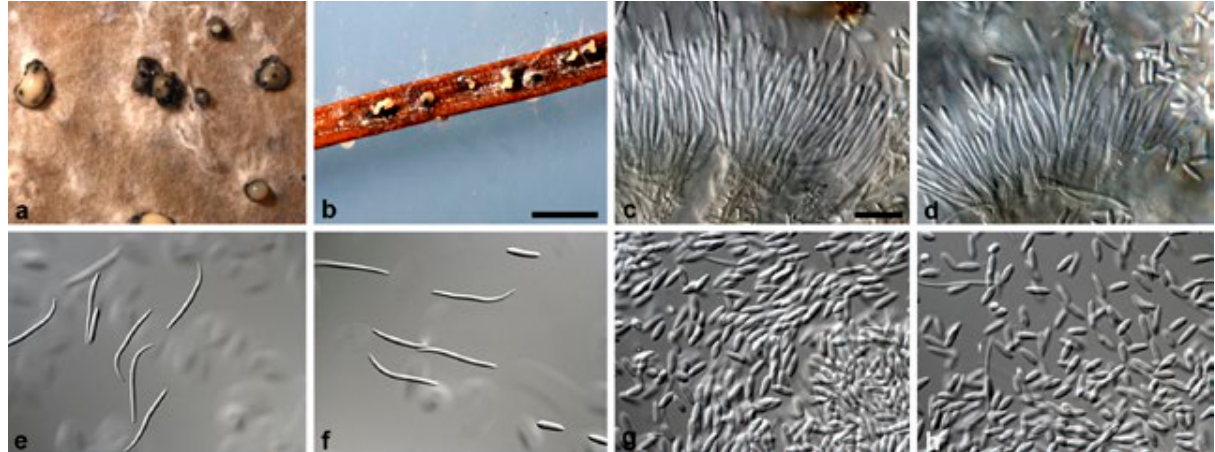
Figure 2 . Diaporthe baccae (ex-type CBS 136972). a. Conidiomata sporulating on OA; b. Conidiomata sporulating on PNA; c, d. Conidiogenous cells. e, f. beta conidia; g, h. alpha conidia. Scale bars b = 500 µm; c = 10 µm (apply to